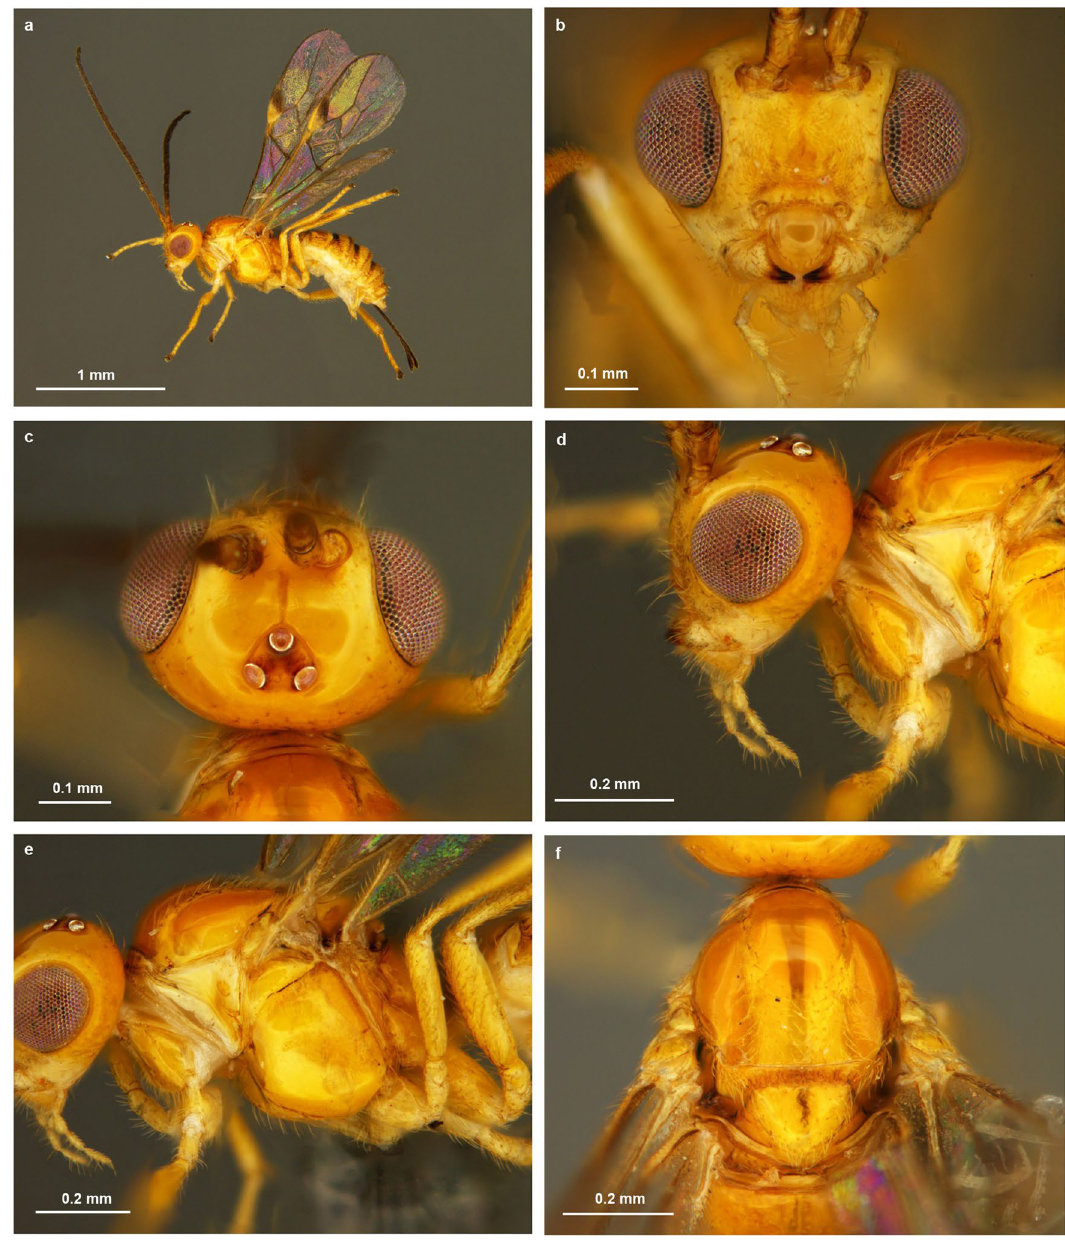
Figure 4. Light microscopic images of Bracon predatorius Ranjith & Quicke sp. nov., holotype, female. ( a ) Habitus, in lateral view, ( b ) head, in anterior view, ( c ) head, in dorsal view, ( d ) head, in lateral view, ( e ) mesosoma, in lateral view, ( f ) mesosoma, in dorsal